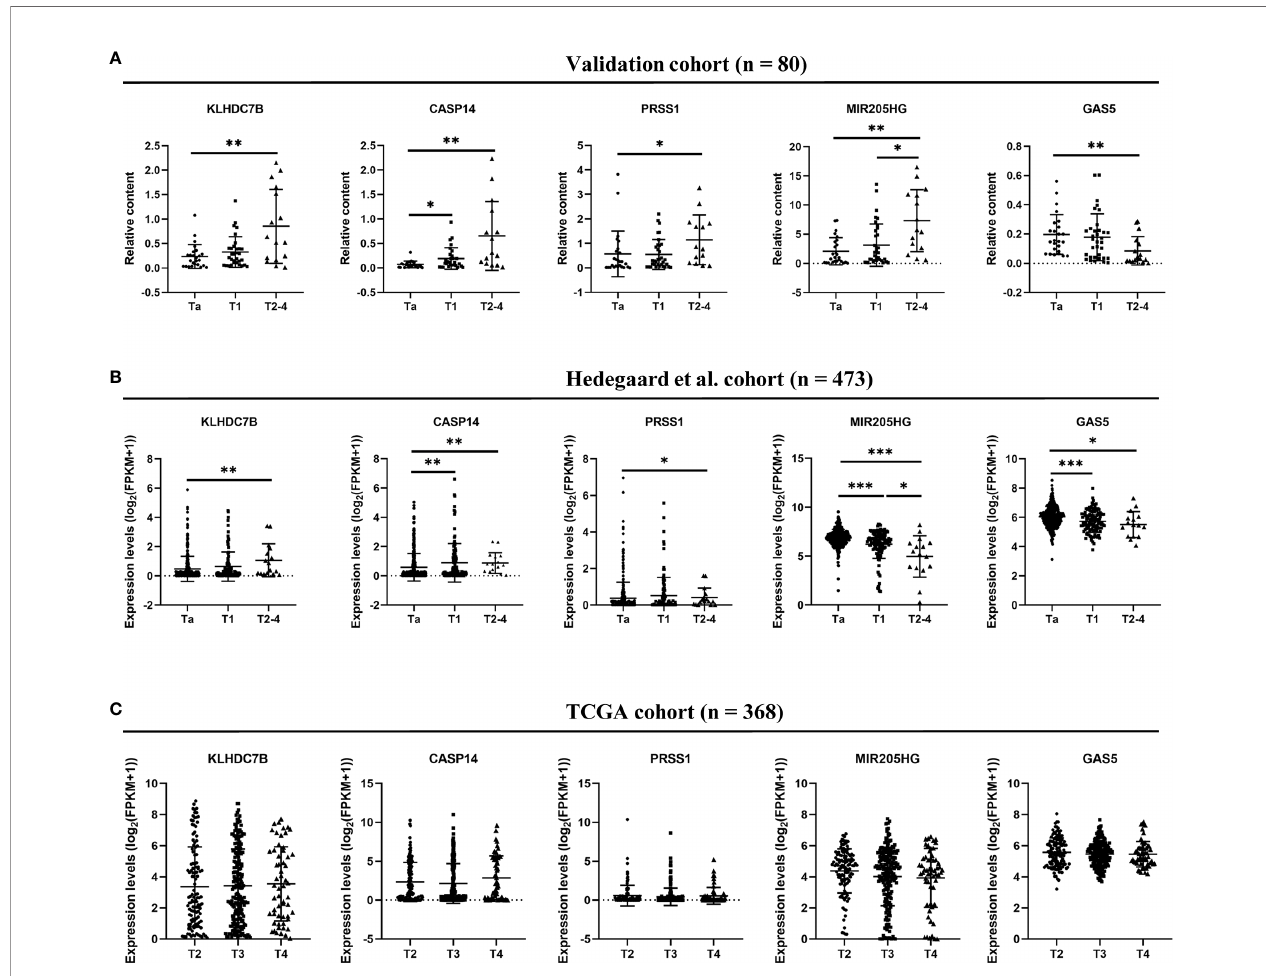
FIGURE 8 | Comparison of fi ve RNAs expression levels among different BCa stage in urine exosomes (A) , Hedegaard et al. (24) validation cohort (B) , and TCGA validation cohort (C) . *P < 0.05, **P < 0.01, ***P < 0.001.